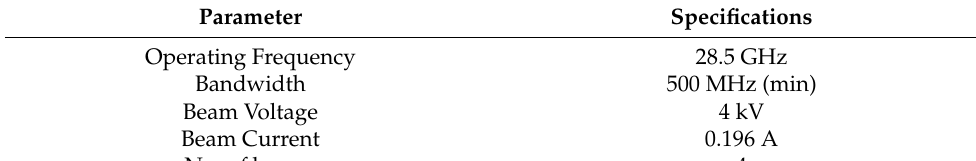
Table 1. Design specification of proposed multiple beam klystron.